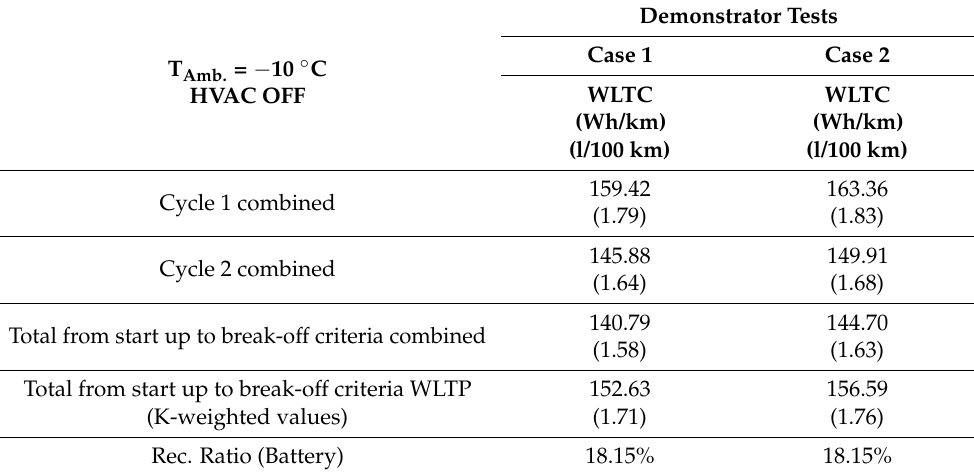
Table 6. Energy consumption results (Wh/km) for the WLTP CCT tests at cold temperatures of the demonstrator vehicle without the HVAC system in operation. Results for the two measurement cases (Case 1—CAN current and CAN voltage measurements; Case 2—AC/DC clamp for current and CAN voltage